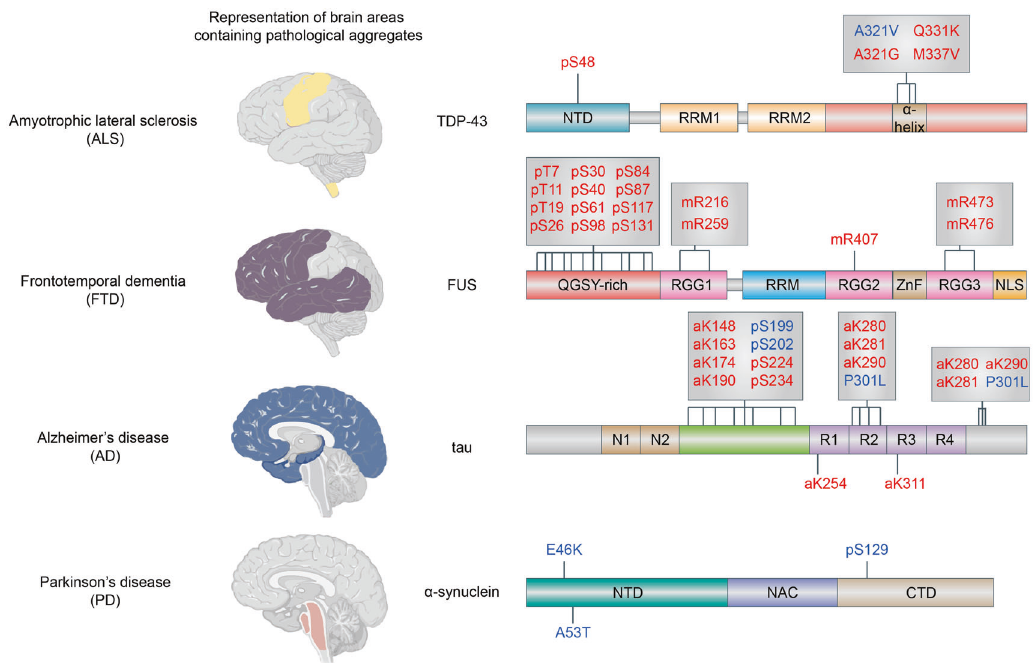
Fig. 7 Phase separation in neurodegenerative disease. Schematic representation of brain areas containing pathological aggregates of four kinds of neurodegenerative diseases. This fi gure also summarizes disease-associated mutations and PTMs that decrease (red) or enhance (blue) LLPS compared with unmodi fi ed TDP-43, FUS, a-synuclein, or tau, as indicated. NTD: N-terminal domain, RRM: RNA-recognition motif, QGSY-rich: rich in glutamine, glycine, serine, and tyrosine, RGG: arginine/glycine-rich; ZnF, zinc fi nger; NLS, nuclear localization signal; NAC, non-Ab component of AD plaque; N1 – 2, polypeptide sequences encoded by exons 2 and 3; PRR, proline-rich regions; R1 – 4, microtubule- binding domains encoded by exons 9 – 12; p, phosphorylation; m, methylation; a,